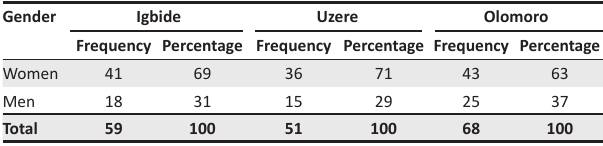
TABLE 3: Gender distribution of study